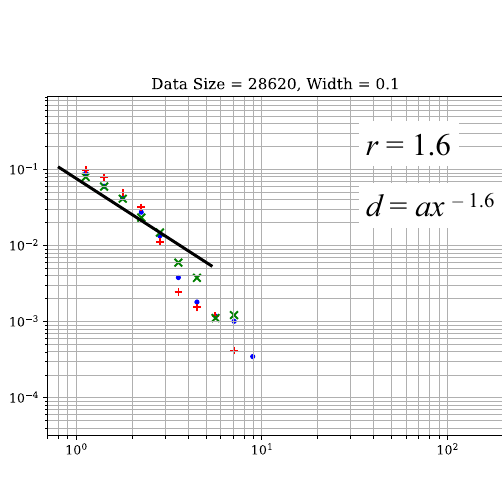
Fig. 10 PDF of time series by TATP of LSTM 10,000 epochs